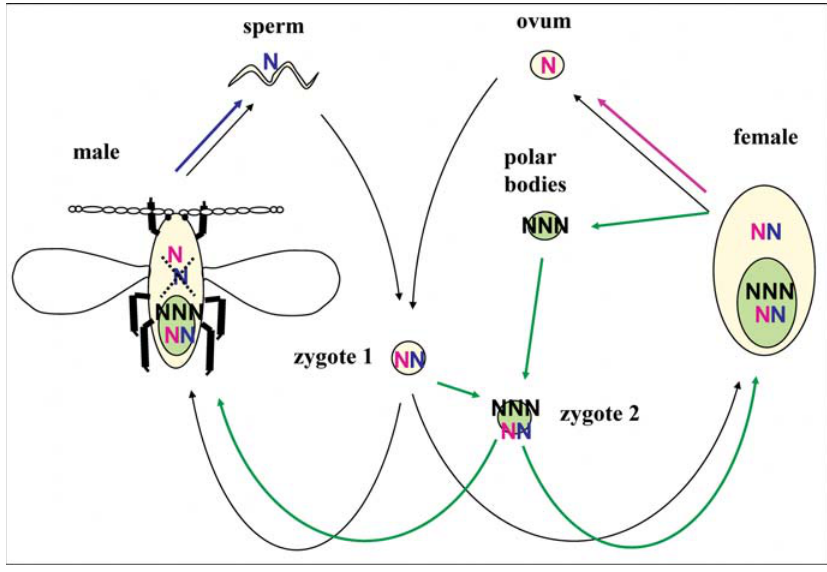
DOI: 10.1371/journal.pbio.0020043.g002 Figure 2. Schematic Diagram of the Genetic System of a Diaspidid Scale Insect Zygote 1 is the fertilized ovum from which all organismal tissues except the bacteriome develop (black arrows). The bacteriome develops from zygote 2 (green arrows). Each haploid genome is represented by an N. A haploid genome may come from the oocyte (pink), sperm (blue), or polar bodies (black). The blue and pink arrows emphasize that the maternal versus paternal identity of a haploid genome is reset (imprinted) in each generation; thus, a male transmits only his maternal genome, but in his offspring the same chromosomes behave as a paternal genome (schematically, the pink N is converted to blue during